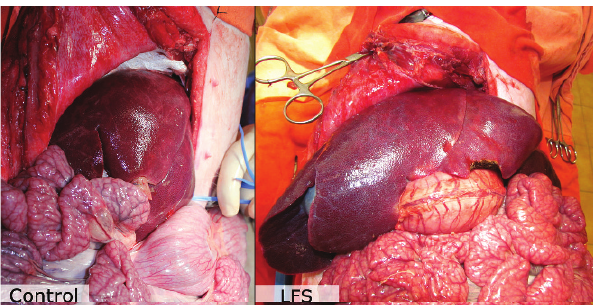
Figure 1 - Surgical characteristics of the control and LFS animals. Note the increased liver mass in the LFS animals.